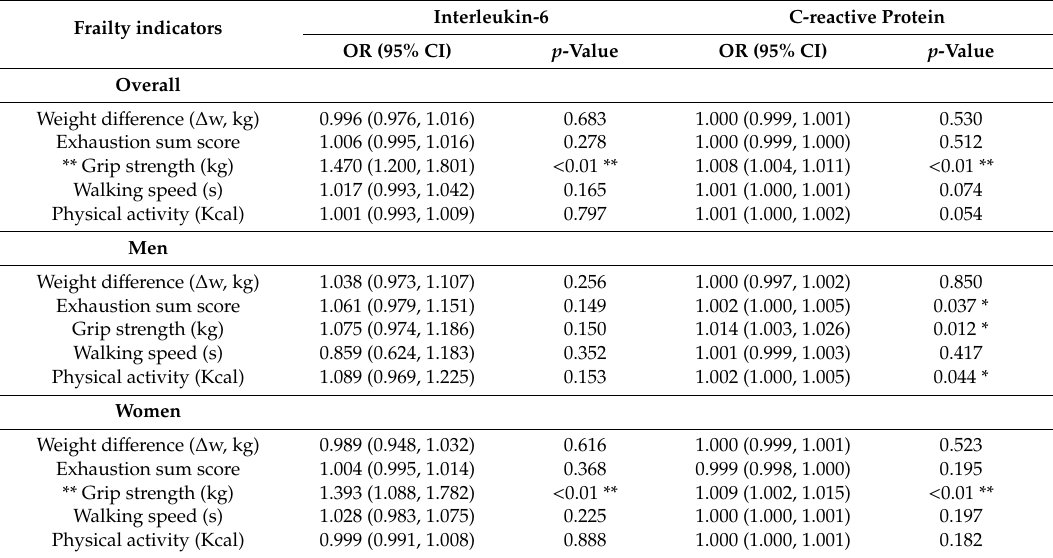
Table 7. Relationship of serum inflammatory biomarkers and the frailty indicators using binary linear regression analysis (odds ratios) with the comparison of gender e ff